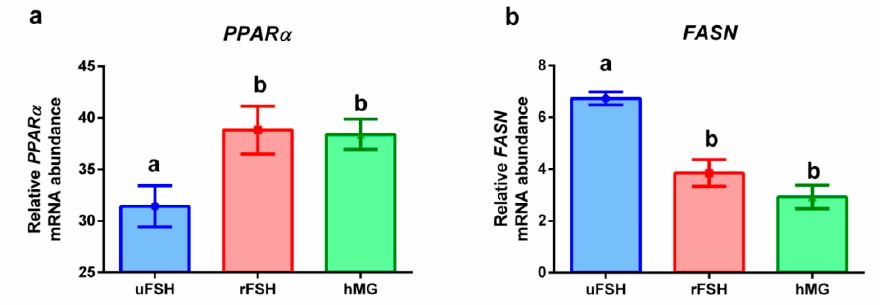
Figure 3. Gene expression profiles: ( a ) PPAR α : peroxisome proliferator activated receptor alpha; ( b ) FASN : fatty acid synthase. Results are reported as mean ± standard deviation. Statistical significance was set at p < 0.05 and calculated by ANOVA followed by Tukey’s multiple comparisons test. Different letters above columns indicate statistical differences among groups.